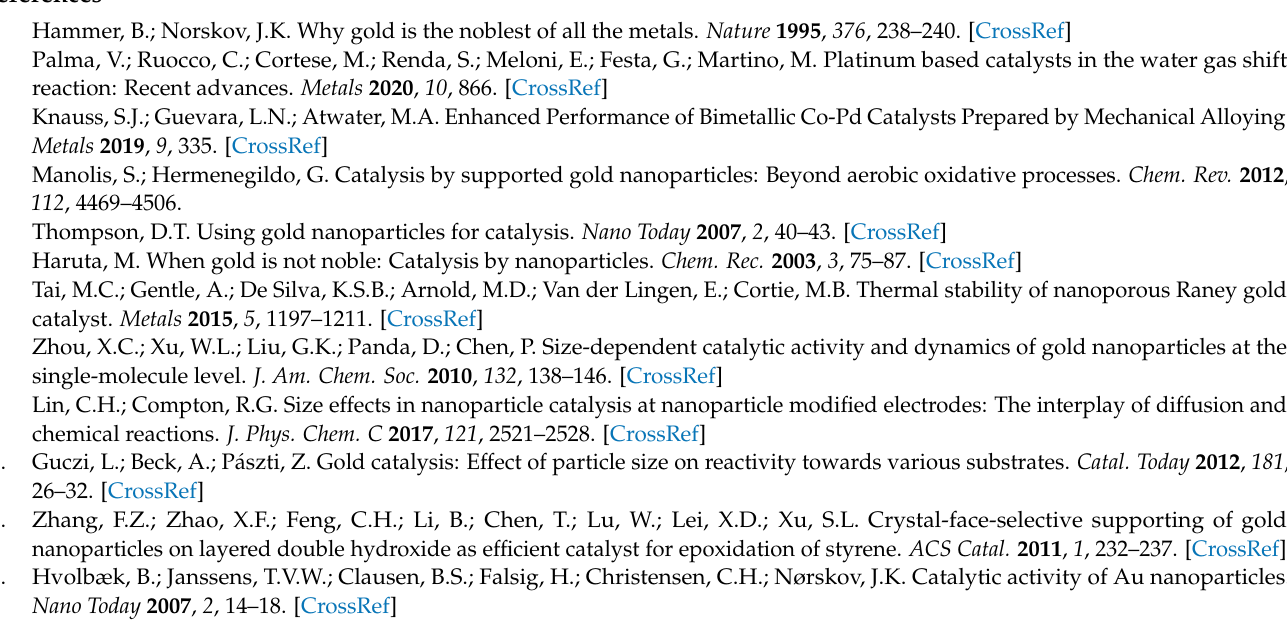
Table S14: The simulation data from Ouyang’ model of Au nanoparticles in 300 K; Table S15: The Linear relationship between the chemical bond energy and vacancy formation in common metal materials; Table S16: Linear relationship between vacancy forming energy and diffusion activation energy in common metal